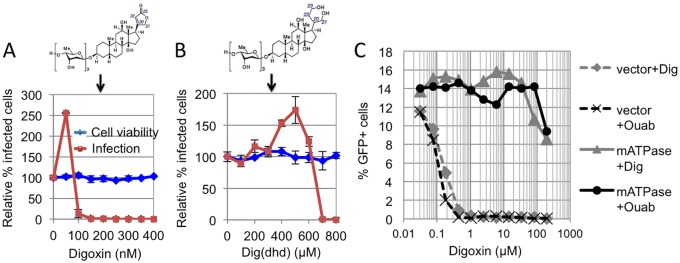
Na+/K+ ATPase is the digoxin target mediating antiretroviral activity in CD4+ T-cells.(A) Jurkat cells were infected with VSV-G pseudotyped HIV-1 LAIΔenvGFP at an MOI of 0.1 in the presence of the indicated doses of digoxin and analysed by flow cytometry 36 hours post-infection. The chemical structure of digoxin is shown at the top. (B) Same as for panel (A) but cells were infected in the presence of Dig(dhd). Dig(dhd) chemical structure is shown at the top. In panels A and B error bars indicate SD, N = 3 independent experiments. (C) Jurkat cells stably expressing the mouse Na+/K+ ATPase (mATPase), or an empty vector (vector), were infected with HIV-1 LAIΔenvGFP at an MOI of 0.1 in the presence of the indicated concentrations of cardiac glycosides digoxin or ouabain, both Na+/K+ ATPase antagonists. The percentage of infected, GFP+ cells was determined by FACS 24h post-infection. Data are representative of 3 independent experiments.